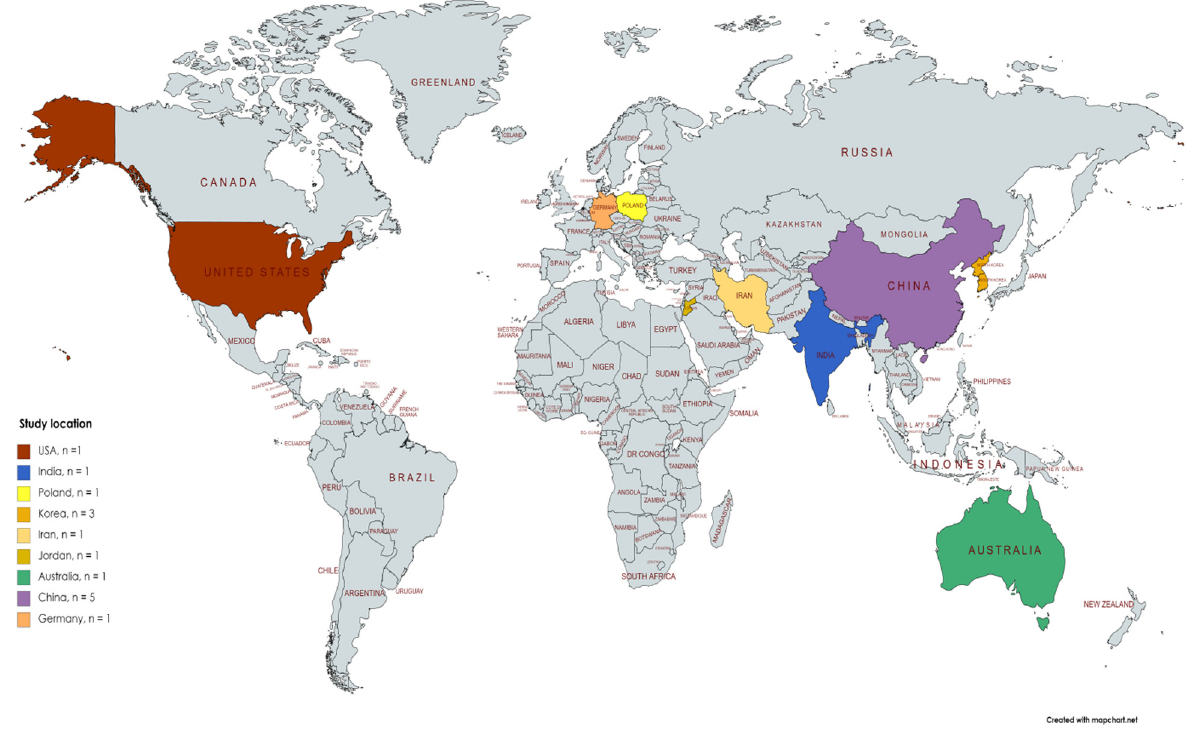
Figure 2: Locations and the frequency of the 15 studies included in the meta - analysis.